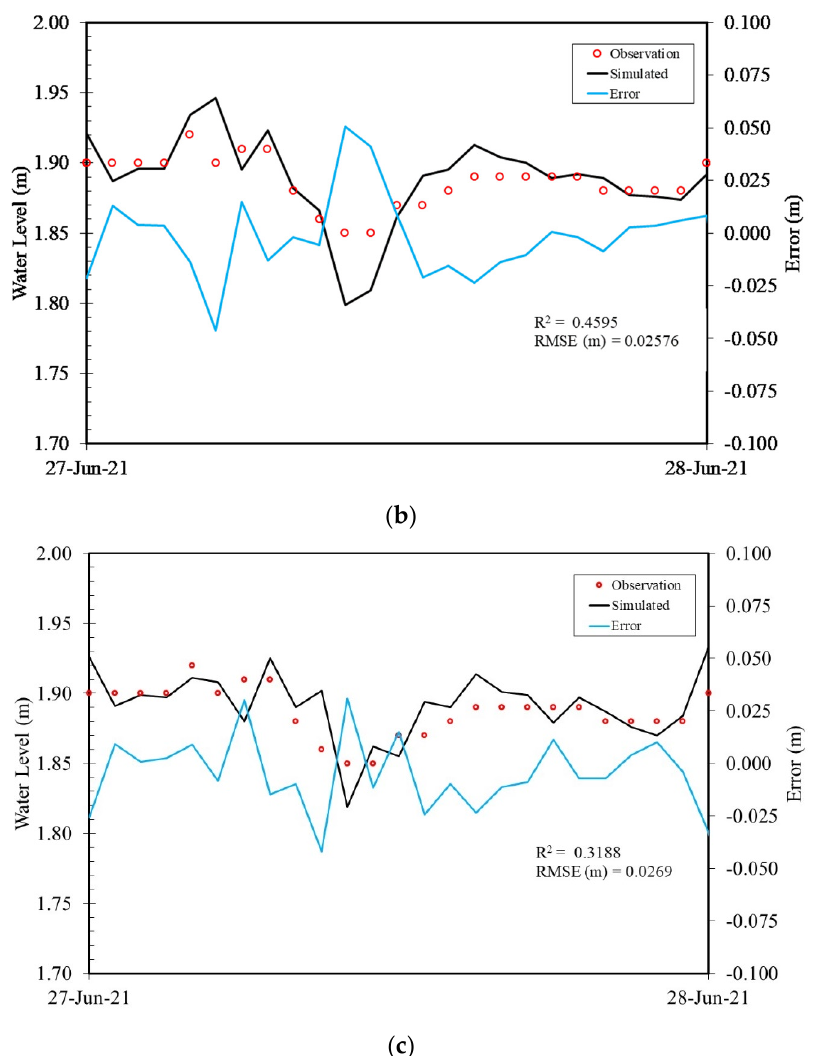
Figure 10. ( a – c ) Comparison of simulation and observed water levels at SC_S2 of Shimen canal for lead times t + 1 h, t + 2, and t + 3 h,